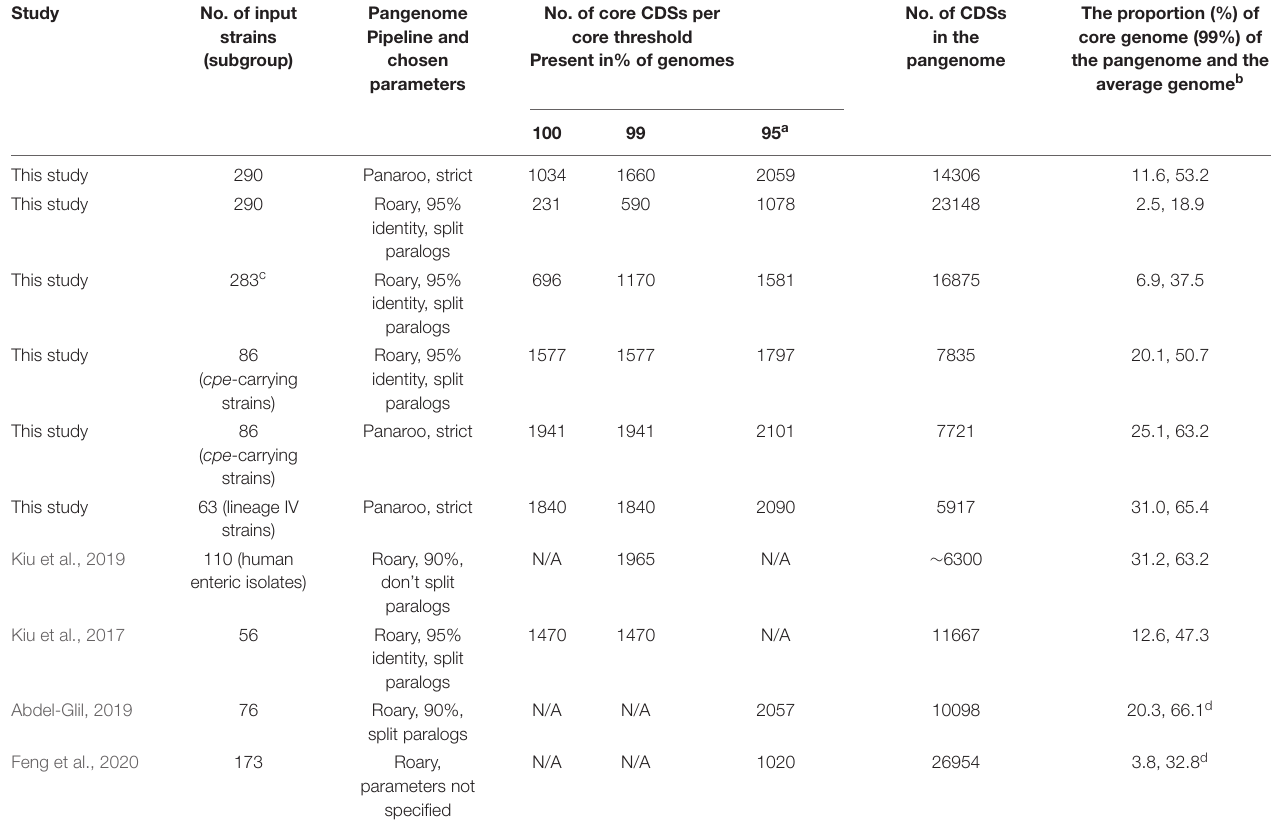
TABLE 2 | Core genome and pangenome estimations of Clostridium